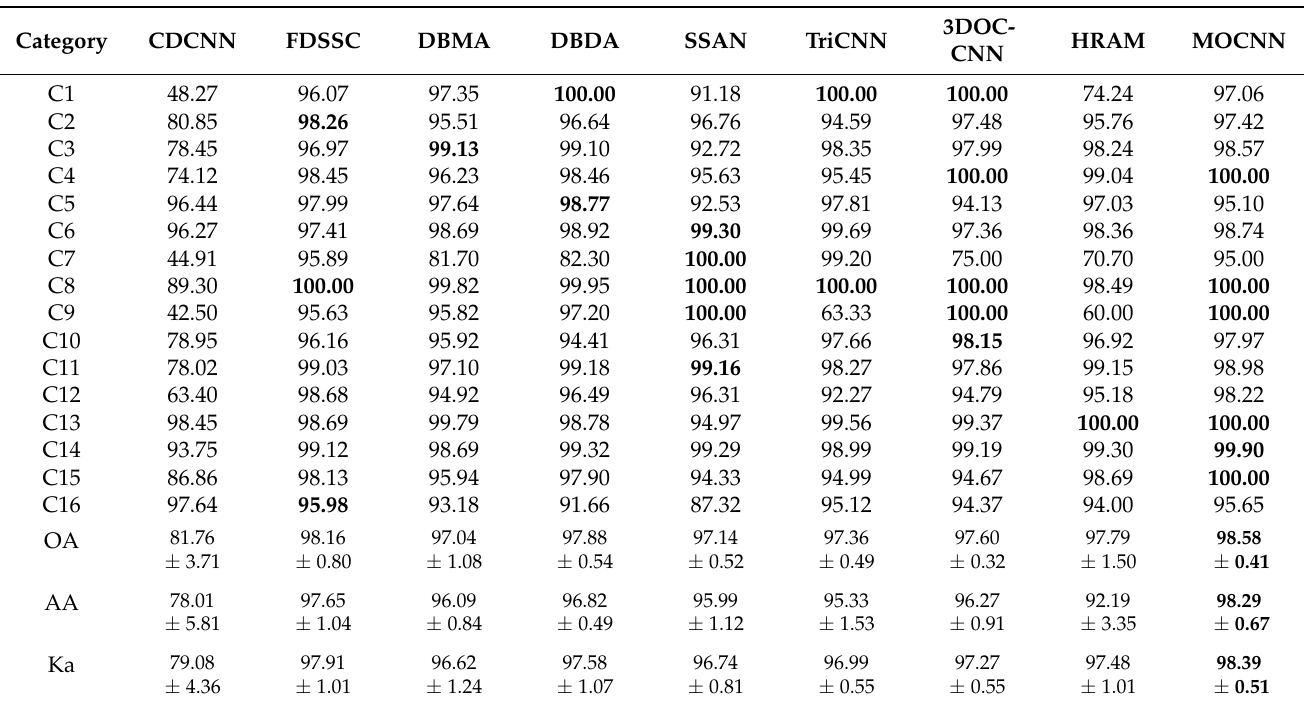
Table 9. Quantitative comparison of the CDCNN [30], FDSSC [31], DBMA [34], DBDA [35], SSAN [24],